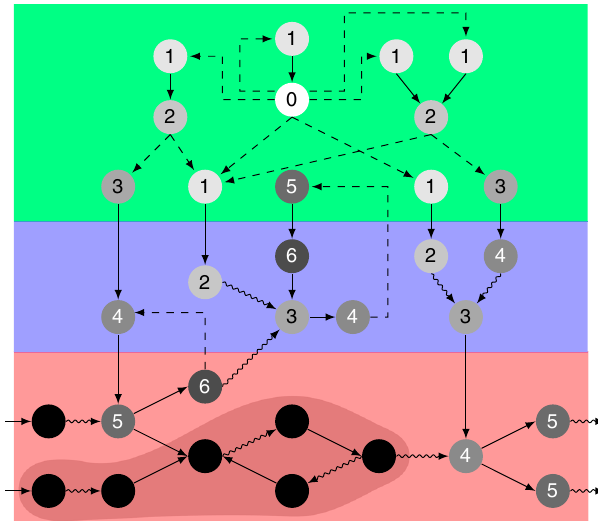
Fig. 2 Sketch of the propagation dynamics of a single-vertex perturbation. The perturbation in the small sample three-domain organized network with gene regulatory domain ( top , green ), (protein-)interface ( middle , blue ) and metabolic domain ( bottom , red ) is initiated in vertex 0 and spreads according to the percolation model given in Eqs. (1) and (2). The numbers and the grayscale indicate the time step in which the respective vertex has been turned off; black vertices are not affected. The arrow line styles denote the three logical categories of edges: C: curly , D: solid , and R: dashed . In the subsequent steps of the analysis, we consider the largest weakly connected component of the frozen network state (vertices in the dark area ). A more detailed illustration is given in Supplementary Fig.